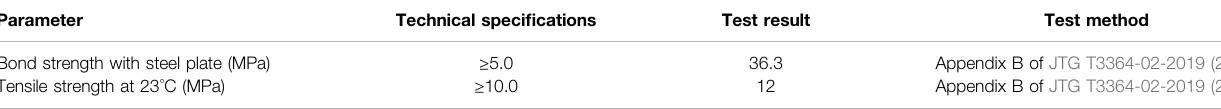
TABLE 2 | Performance indices and test results of epoxy resin.